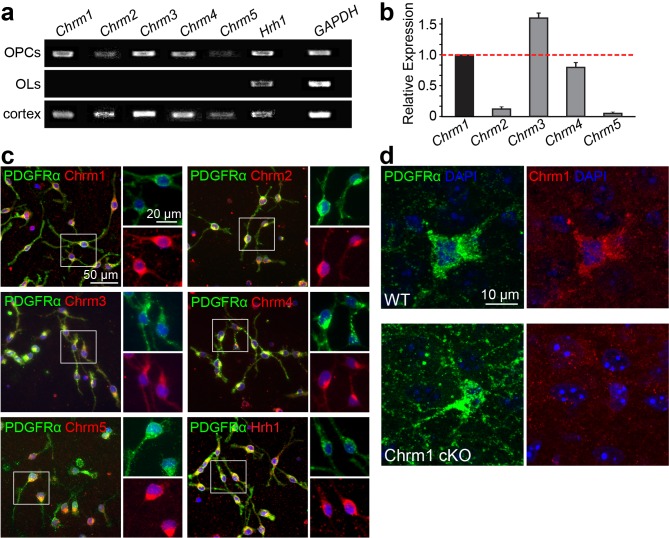
Expression of muscarinic acetylcholine receptors on oligodendroglia.(a) Detection of Chrm1, Chrm2, Chrm3, Chrm4, Chrm5 and Hrh1 mRNA in rat OPC and OL cultures by RT-PCR. Rat cortex cDNA at P8 was used as a positive control and GAPDH as an internal control. (b) mRNA levels for Chrm1, Chrm2, Chrm3, Chrm4, and Chrm5 were quantified by qPCR. in pufiried OPC cultures. (c) Purified OPC cultures were immunostained for Chrm1 (red), Chrm2 (red), Chrm3 (red), Chrm4 (red), Chrm5 (red) or Hrh1 (red) and PDGFRα positive OPCs (green). Cell nuclei are identified by DAPI (blue). (d) The Chrm1 antibody was validated in the Chrm1 cKO mouse in OPCs. Spinal cord sections from WT and Chrm1 cKO mice were immunostained for PDGFRα (green) and Chrm1 (red).